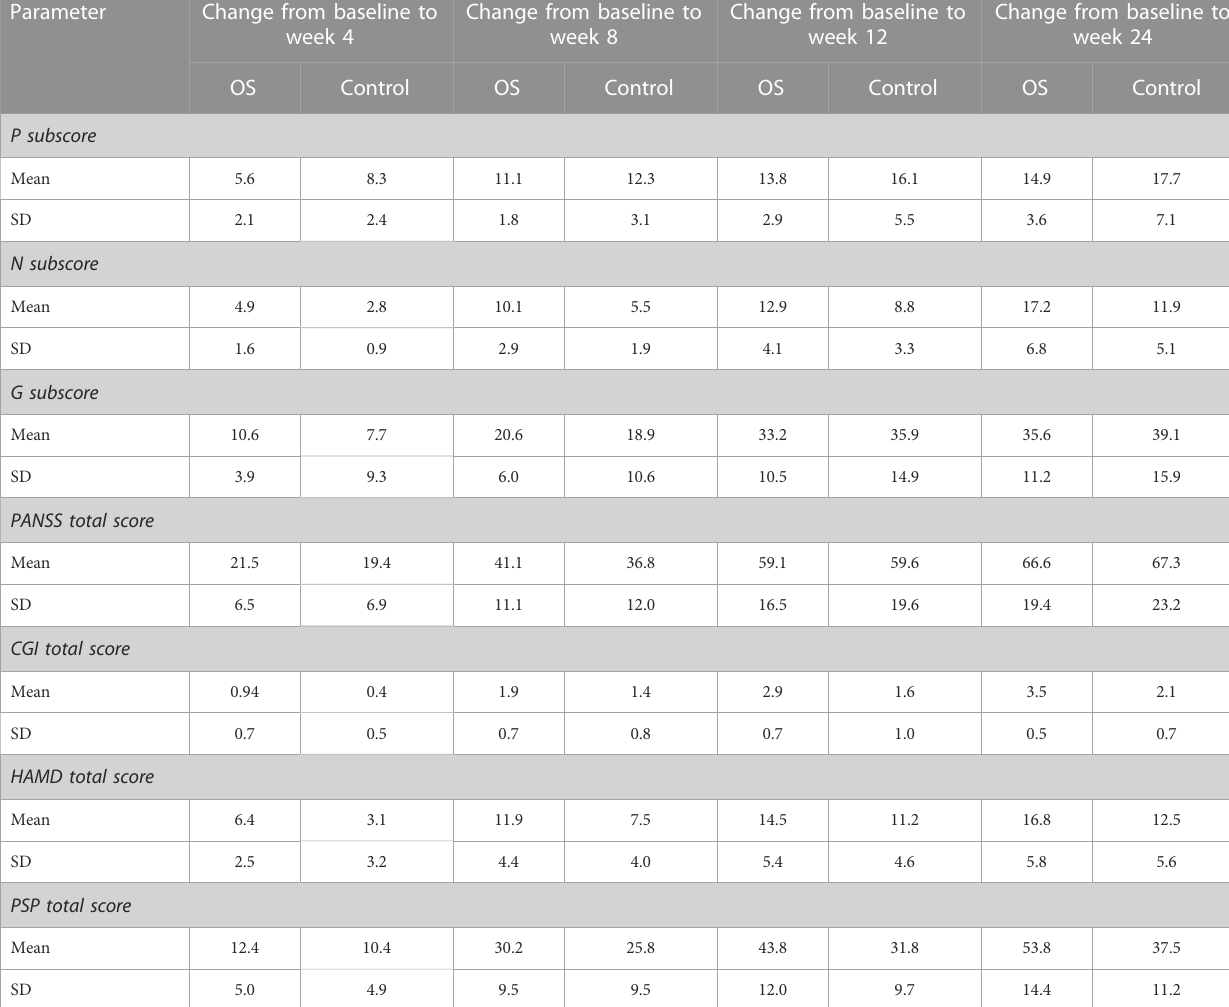
TABLE 3 Psychiatric symptoms and psychosocial functioning at baseline and weeks 4, 8, 12, and 24 in the combination treatment and monotherapy groups.